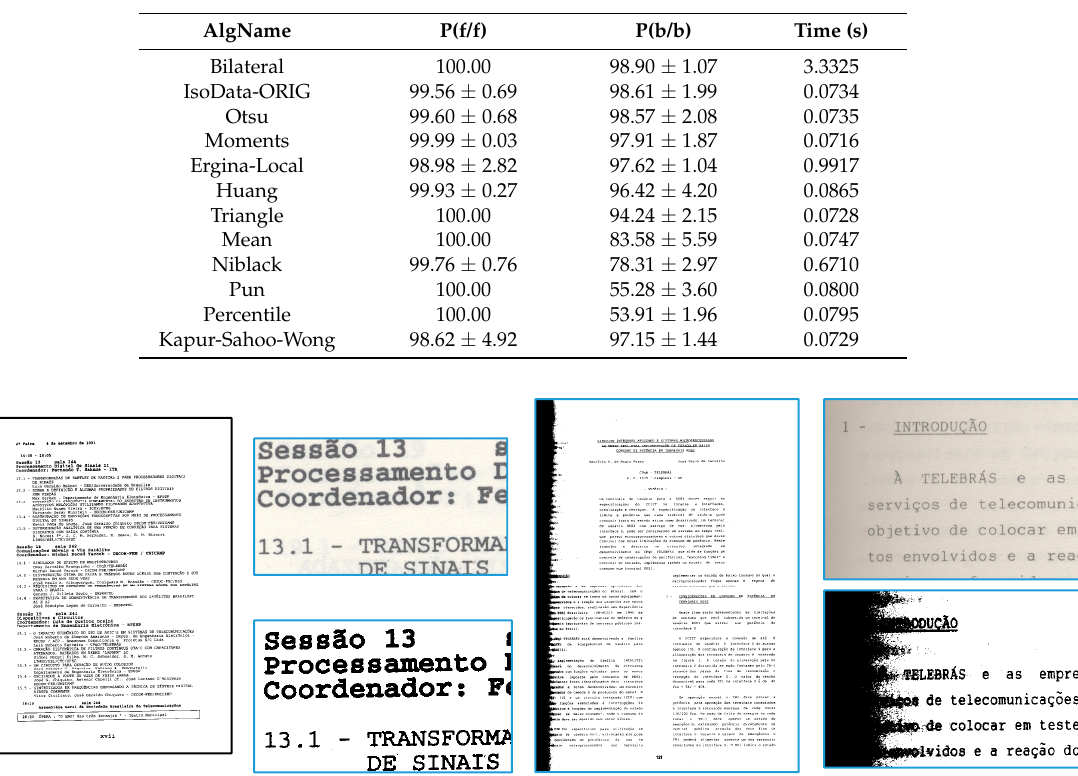
Table 2. Binarization results for images from the LiveMemory project.